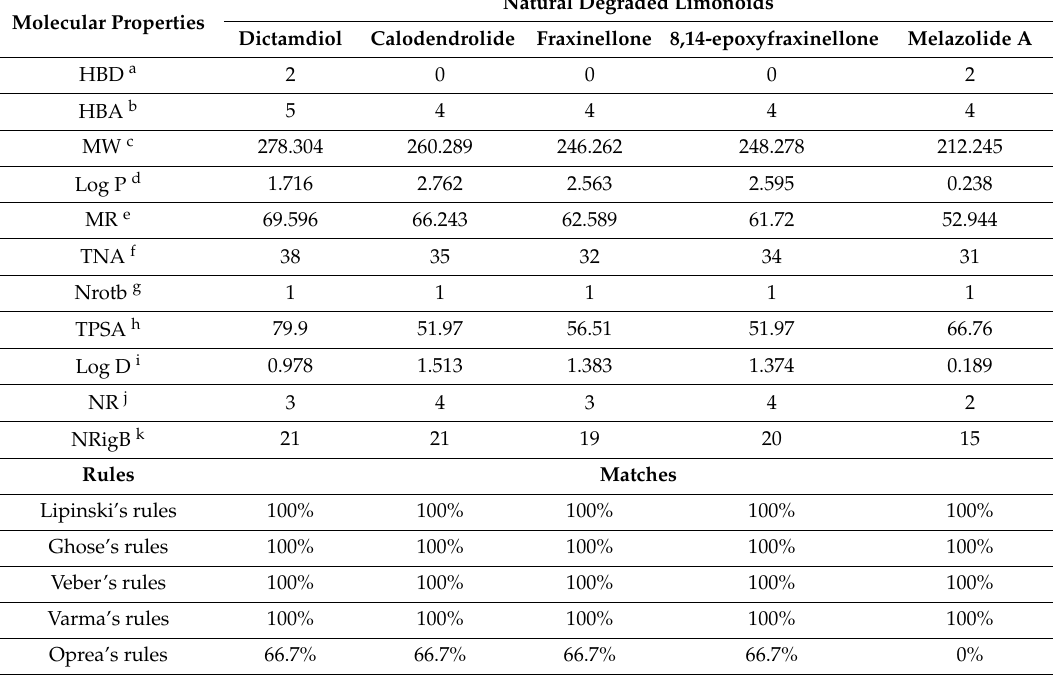
Table 2. Calculated physicochemical properties of the naturally-occurring degraded limonoids dictamdiol, calodendrolide, fraxinellone, 8,14-epoxyfraxinellone, and melazolide A by ADMETlab [28].